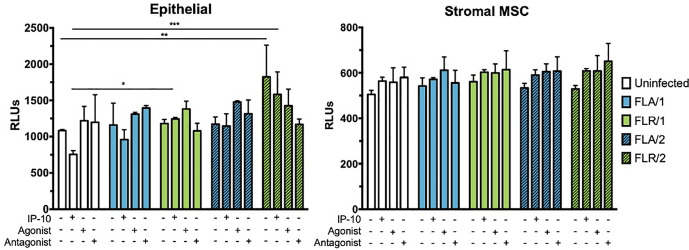
IP-10, CXCR3 agonist, or CXCR3 antagonist do not alter caspase activation during ZIKV prostate infection.Prostate epithelial cells and stromal MSCs were pretreated with IP-10, CXCR3 agonist, or CXCR3 antagonist 3 hours before infection. Cells were infected with ZIKV at an MOI of 0.1 and caspase induction measured at 24 hours post-infection by CaspaseGlo3/7 luminescence assay. Number of cell types used to propagate virus are indicated numerically after ZIKV isolate names. Data are from 2 independent experiments with 2 technical replicates each. Error bars are SEM. Statistical significance was determined using two-way ANOVA followed by multiple comparison t-tests using the Holm-Sidak correction. Significance was * = p<0.05; ** = p<0.01; *** = p<0.005; **** = p<0.001.